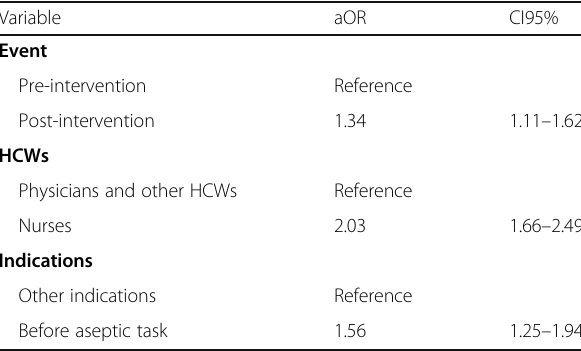
Table 3 Binary logistic regression model of potential factors determining hand hygiene compliance at University